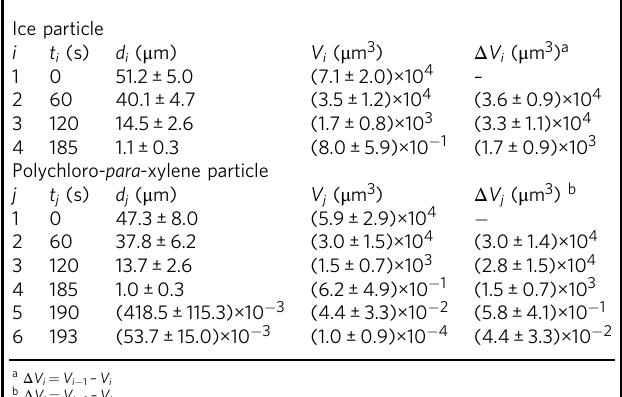
Table 1 Statistical results of the diameter ( d i , d j ) and volume ( V i , V j ) for ice and polychloro- para -xylylene particles obtained with time variable ( t i , t j